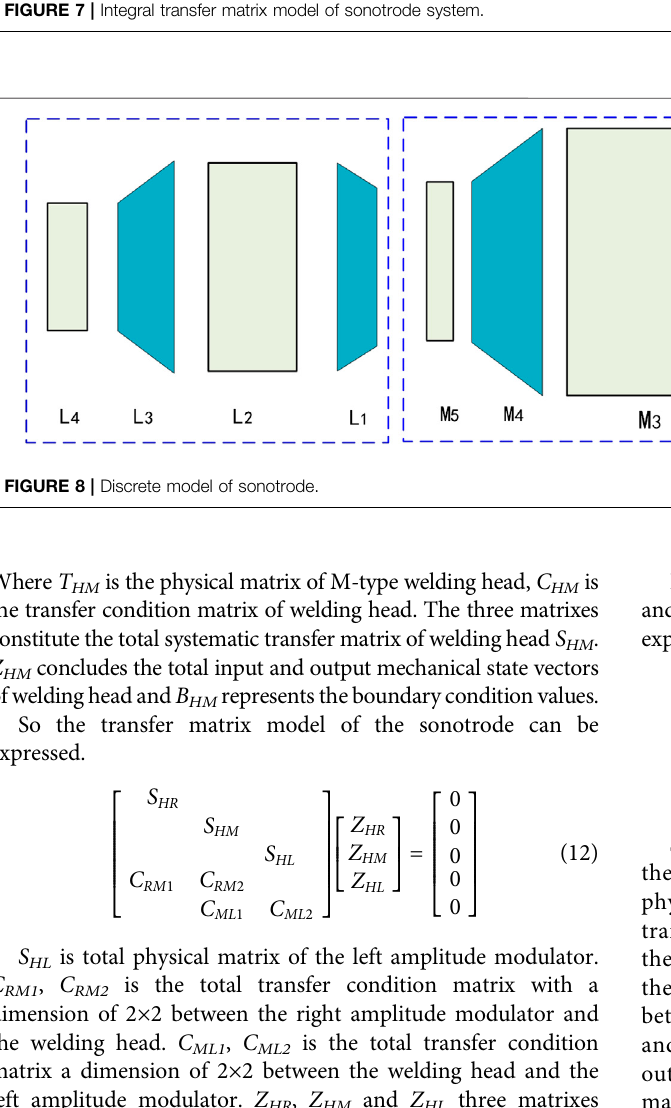
FIGURE 7 | Integral transfer matrix model of sonotrode system.